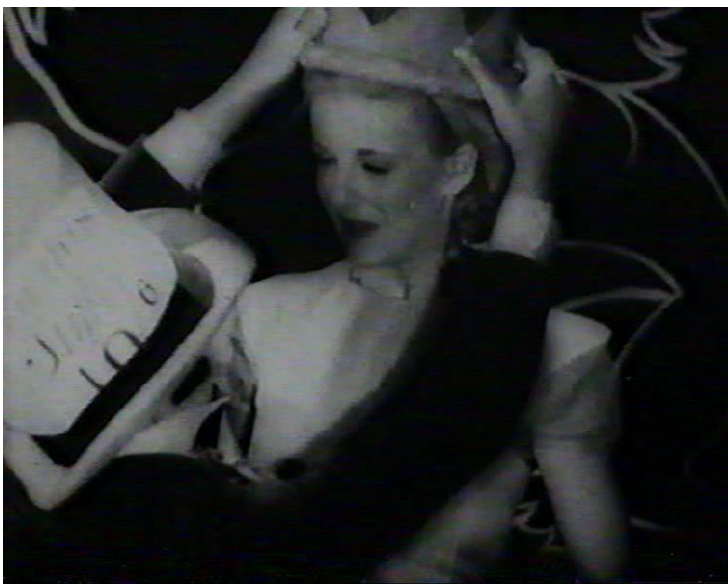
Figure 2. In the play-in-the-film of Puttin’ on the Ritz (Edward H. Sloman, 1930), Dolores (Joan Bennett) is crowned as “Alice in Wonderland.”